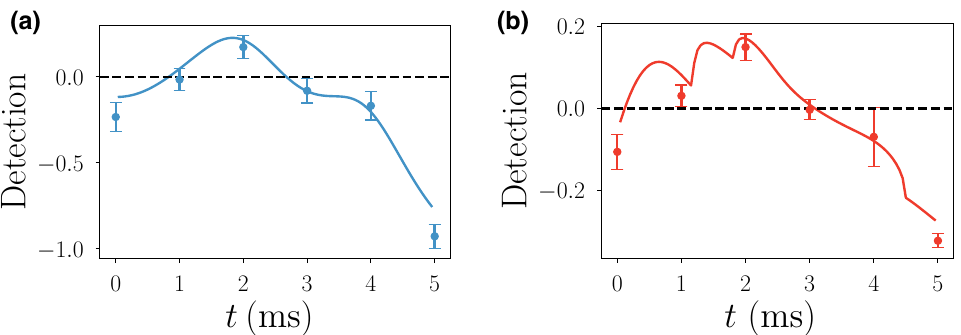
(ρ ) − 1 ) . We detect entanglement between AB 2 n